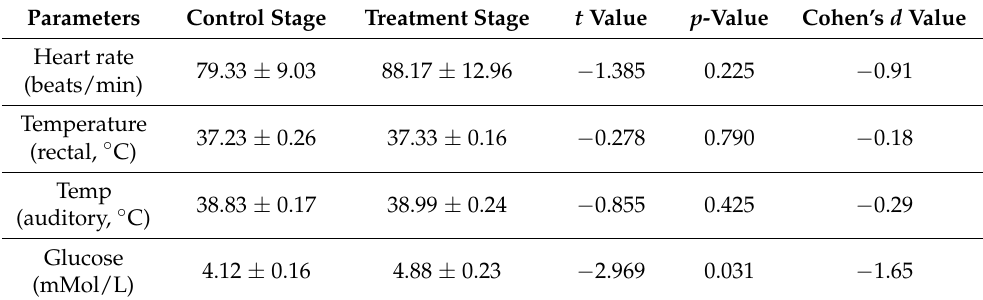
Table 2. Differences in heart rate, body temperature, and glucose in goats upon exposure to act of